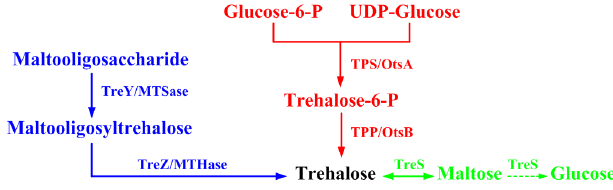
Fig 1. Biosynthesis of trehalose by three different